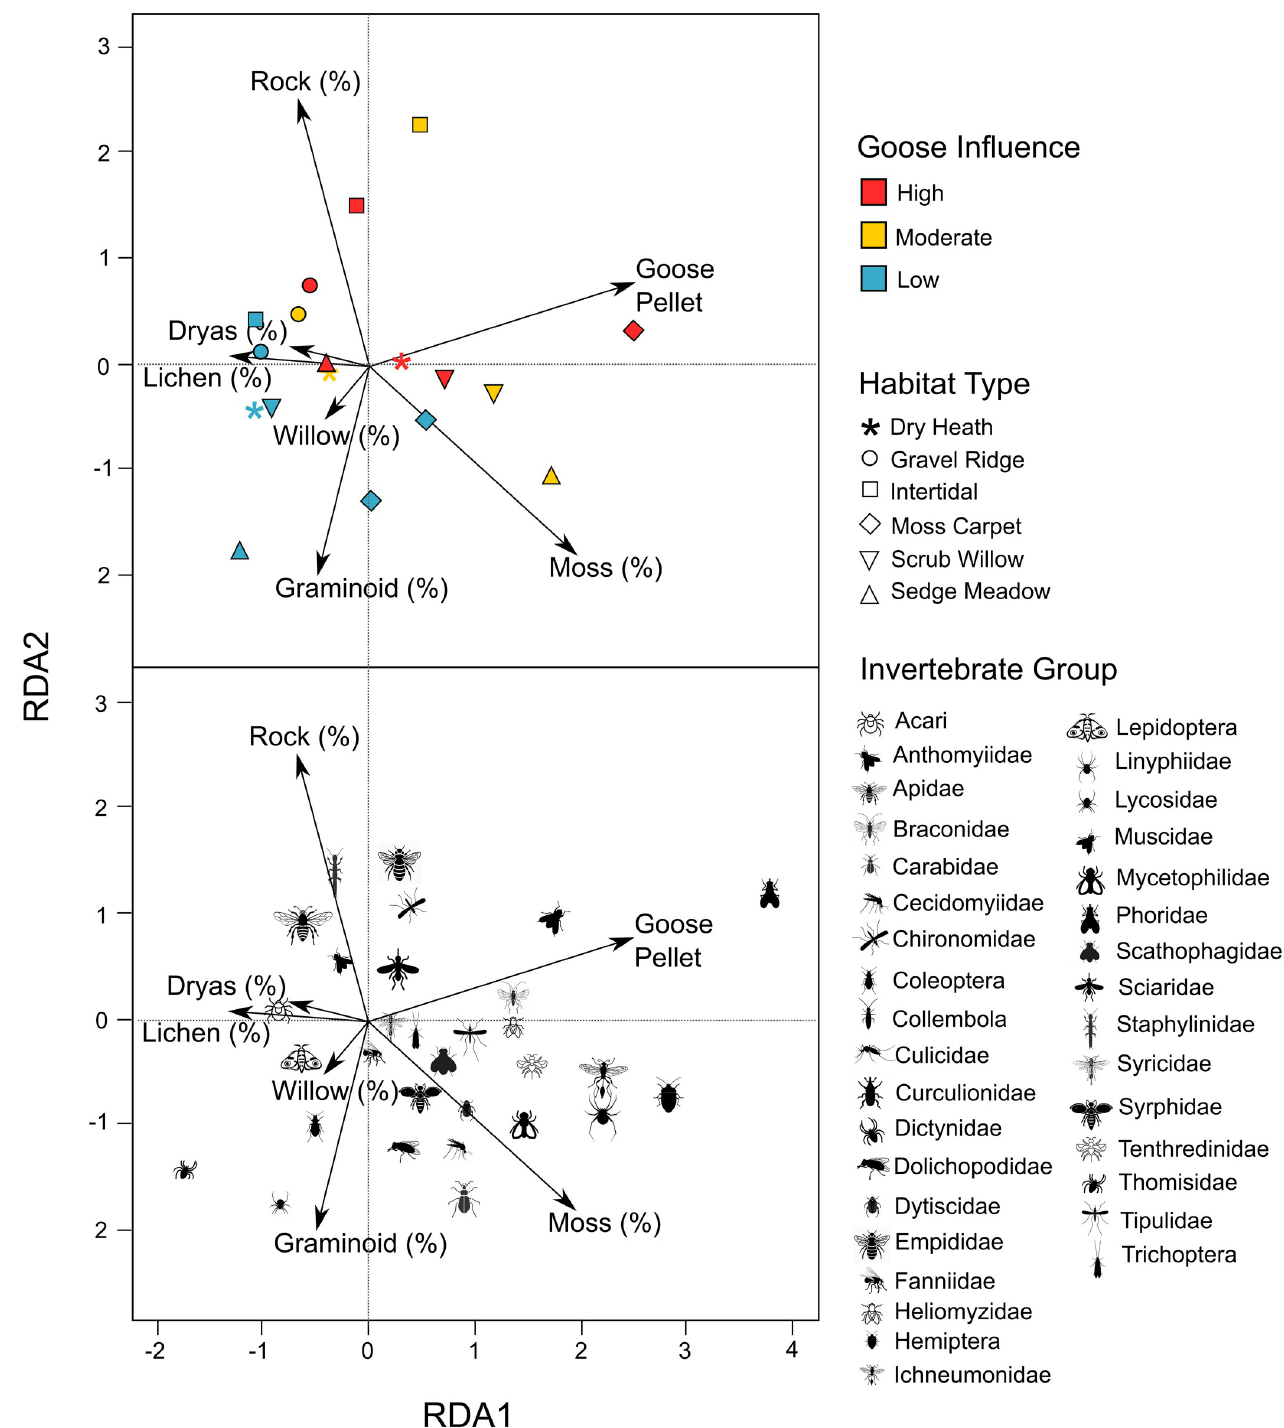
Fig 3. Ordination plots for redundancy analysis of invertebrate communities across study sites and habitat types. (top) Ordination showing the average RDA scores for three study sites with varying goose influence and six habitat types. (bottom) Ordination showing the effects of environmental variables on each invertebrate taxon. Goose pellets, moss cover, and graminoid cover were all significant environmental variables.